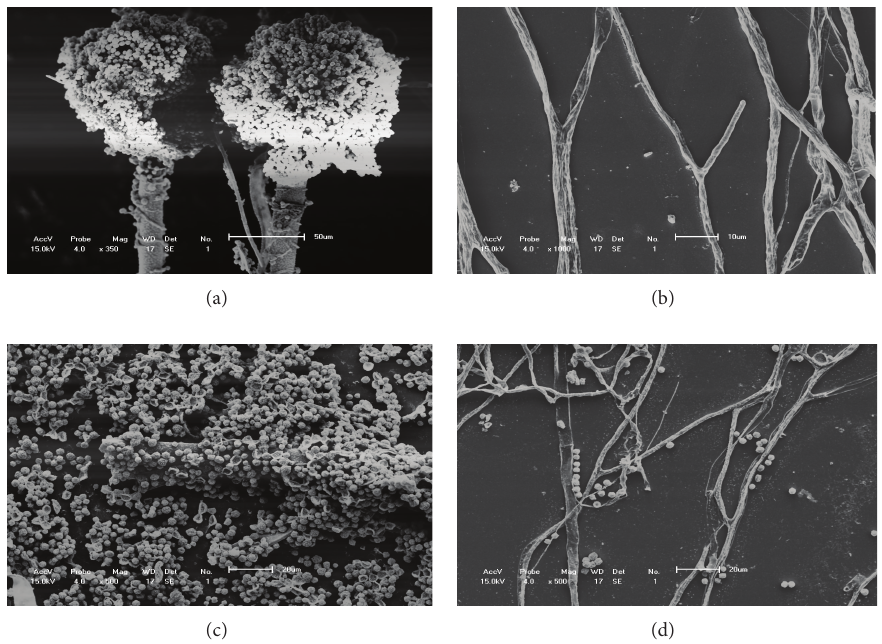
Figure 2: Scanning electron microscopy illustrates the effect of essential oil from C. longa on A. flavus morphology ((a), (c) positive control, (b), (d) fungi cultivated with 2.5% C. longa essential